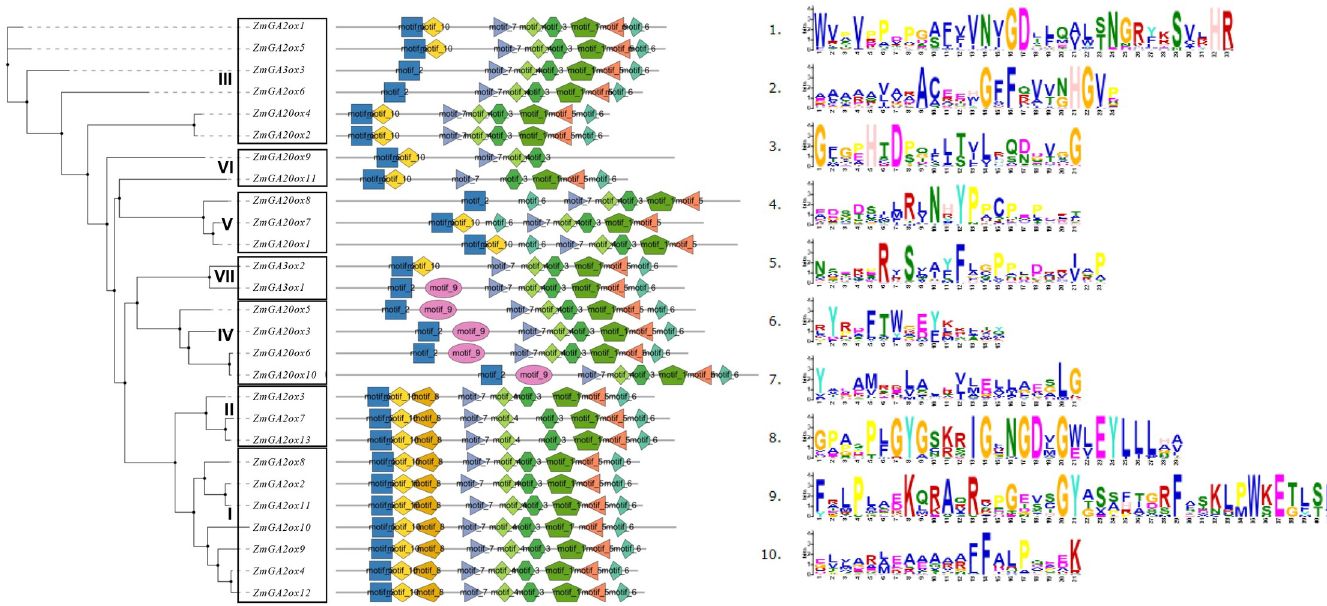
Fig 4. Phylogenetic relationships and conserved motifs compositions of the 27 gibberellin-dioxygenases genes in maize. MEME was used to predict conserved motifs. Each motif is represented by a different colored box. Amino acid sequences of gibberellin-dioxygenases genes were used to build the phylogenetic tree. Prottest was firstly use to predict the best evolution model and JTT+G+I+F as the best evolution model to build the evolution tree using RAxML 1000 bootstrap and the phylogenetic tree visualization is done using Figtree software.